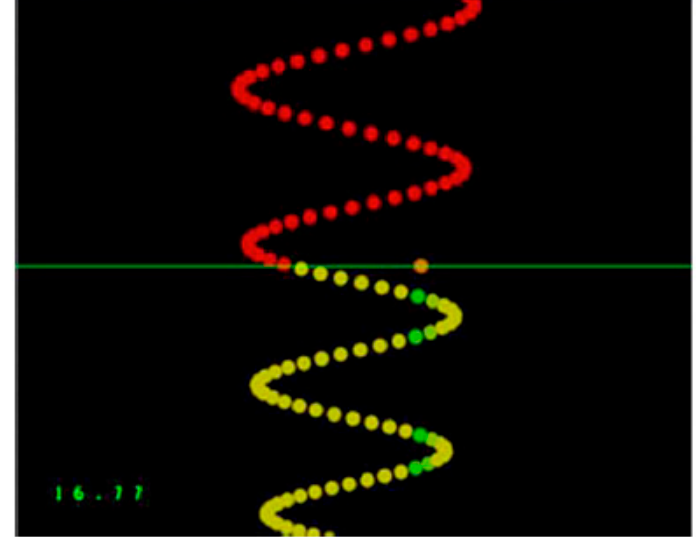
Figure 2. A photograph of the motor learning task that was performed by each participant. The traces consist of a series of dots which the participant tracked when the trace passed a horizontal line. The orange dot shows the location of the participant’s cursor along the horizontal line. Motor error was calculated as the average distance that the cursor was from the optimal trace.